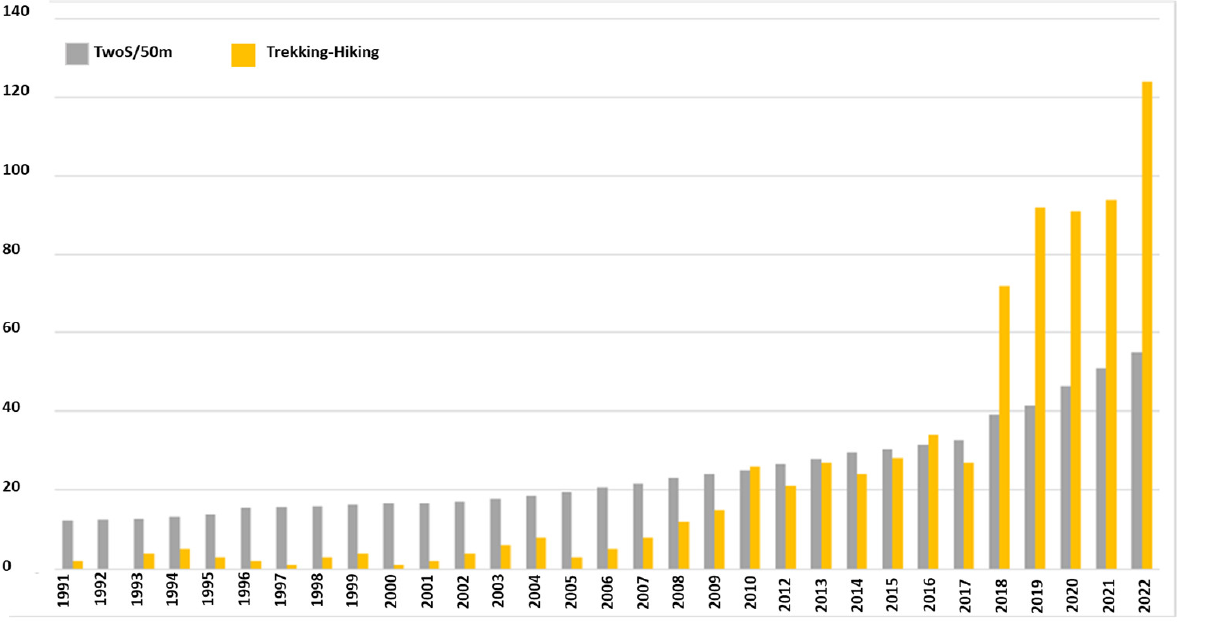
Figure 2. Number of trail tourism publications from 1991 to 2022 in WoS.